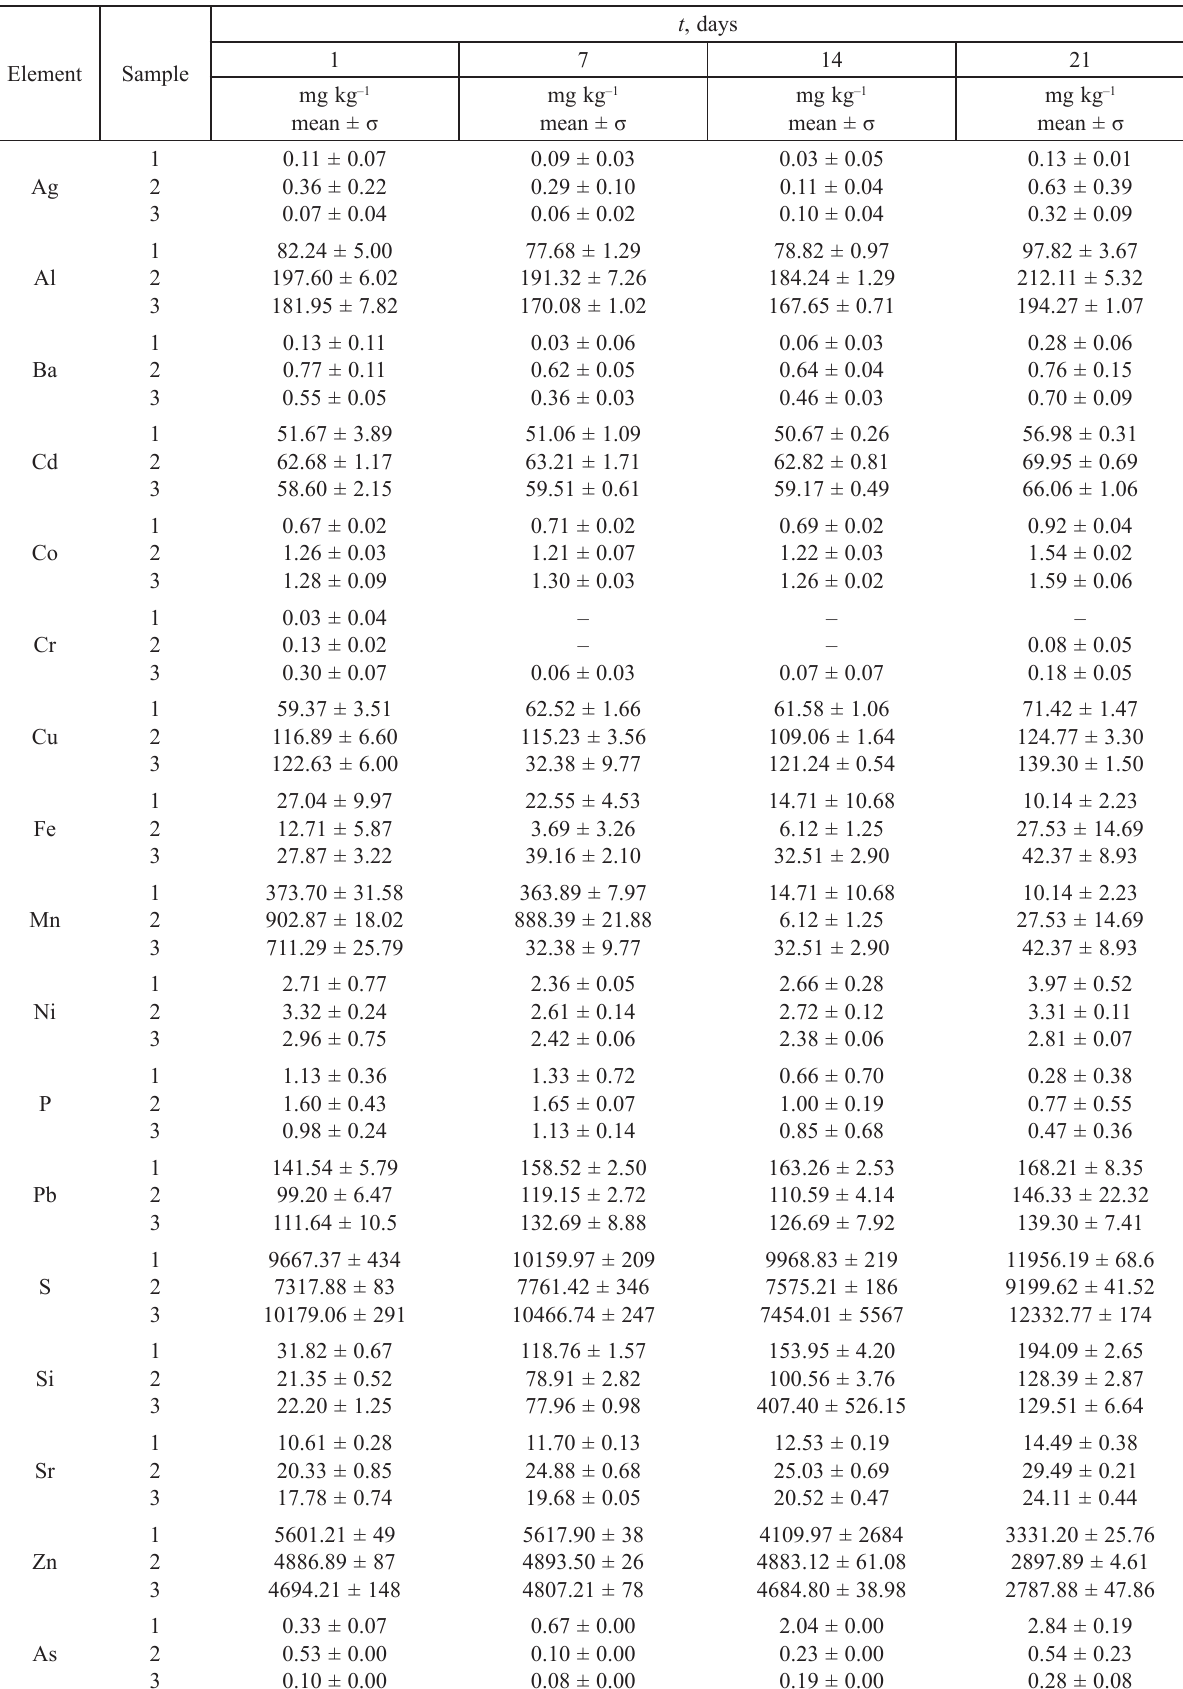
Table 2 – Average concentration of major and minor elements in samples leached with deionized water